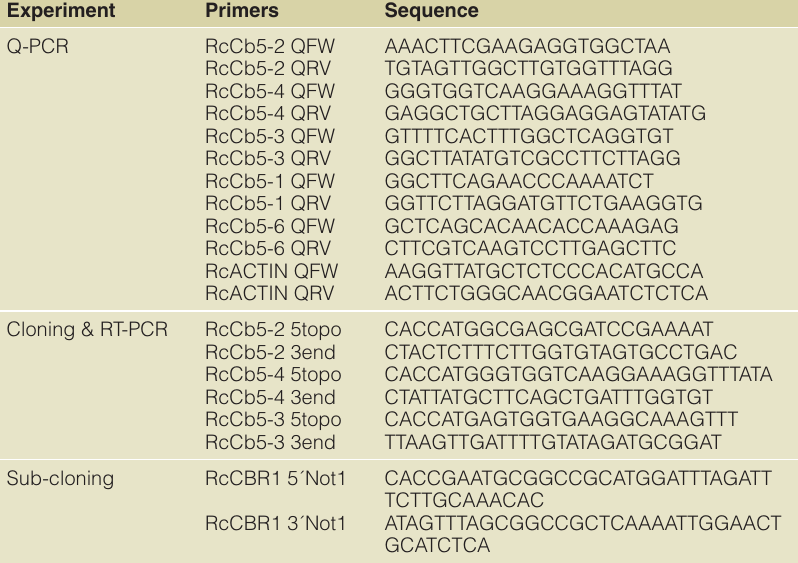
Figure S1. Total HFA accumulation in AtCBR1 CL37 primary transformants. Total HFA (18:1-OH+18:2-OH) contents of mature T individual transformants expressing AtCBR1 in CL37. Control at left is mean HFA in untransformed CL37 plants grown alongside the T For the control, error bar indicates standard deviation, n=12.